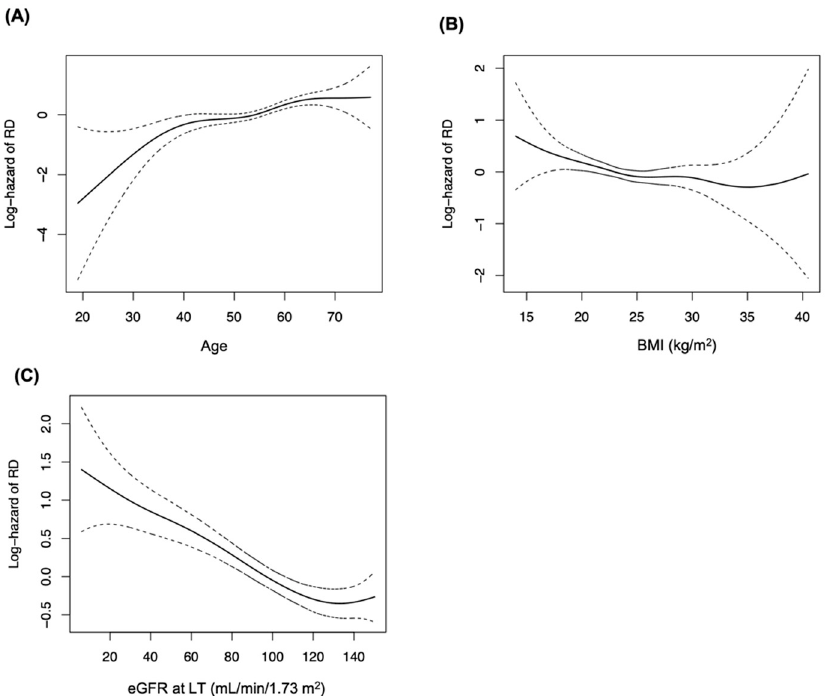
Figure 3. Smoothing splines showing the relation between continuous baseline variables and ad- justed hazard of CKD. Splines of significant variables only were depicted, and the hazard of each variable was adjusted with all other variables. ( A ) Age, ( B ) BMI, ( C ) eGFR at LT. BMI, body mass index; CKD, chronic kidney disease.